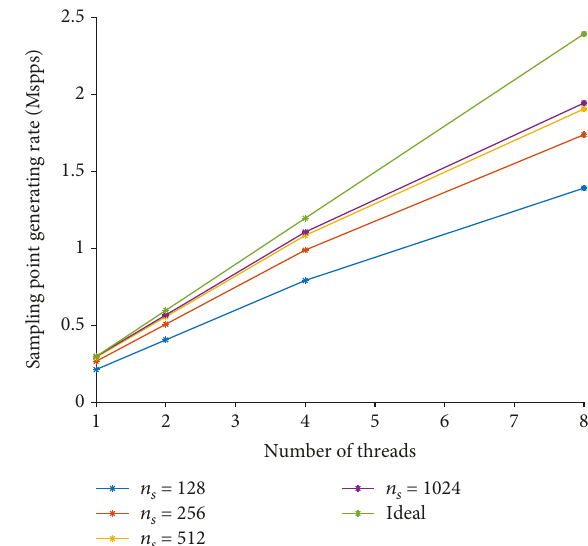
Figure 13: T E obtained from the nonuniform burnback model.